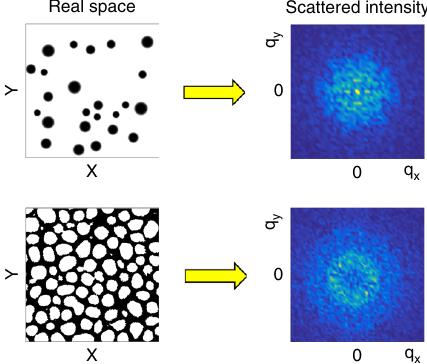
Fig. 1 Schematic of the experimental setup. A femtosecond optical pulse Fig. 2 Schematic examples of scattered intensities from real-space features. randomises the spin degree of freedom and a subsequent circularly The left column shows real-space patterns while the right column shows polarised X-ray pulse probes the perpendicular magnetisation, m z , at a the corresponding scattered intensity computed via Fourier transform with colour scale in arbitrary units. In the top row, a random distribution of given delay, Δ t . For each time delay, the two-dimensional X-ray scattering circular, localised textures gives rise to a broad feature centred at q = 0 in intensity map is obtained, from which the spin – spin correlation function can the scattered intensity. In the bottom row, localised textures possessing be extracted. X-ray magnetic circular dichroism is simultaneously long-range correlations result in a ring pattern in the scattered intensity measured by the un-scattered beam NATURE COMMUNICATIONS| (2019) 10:1756